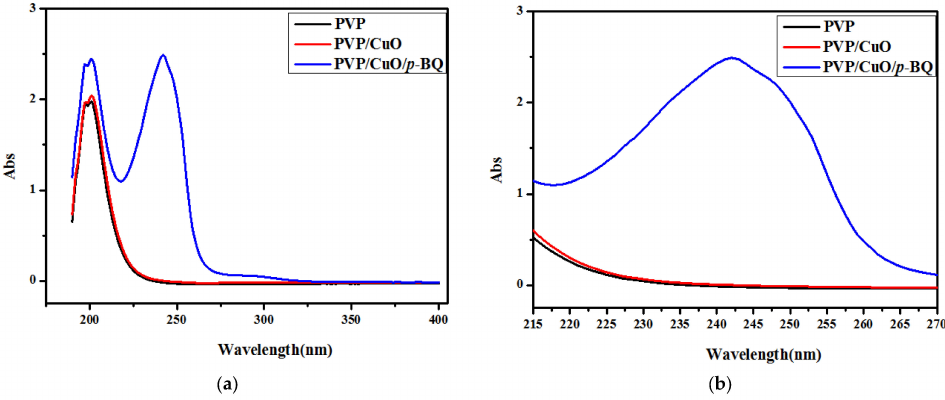
Figure 5. ( a ) and ( b ) UV–vis spectrum of PVP, PVP/CuO, and PVP/CuO/ p -BQ composites.